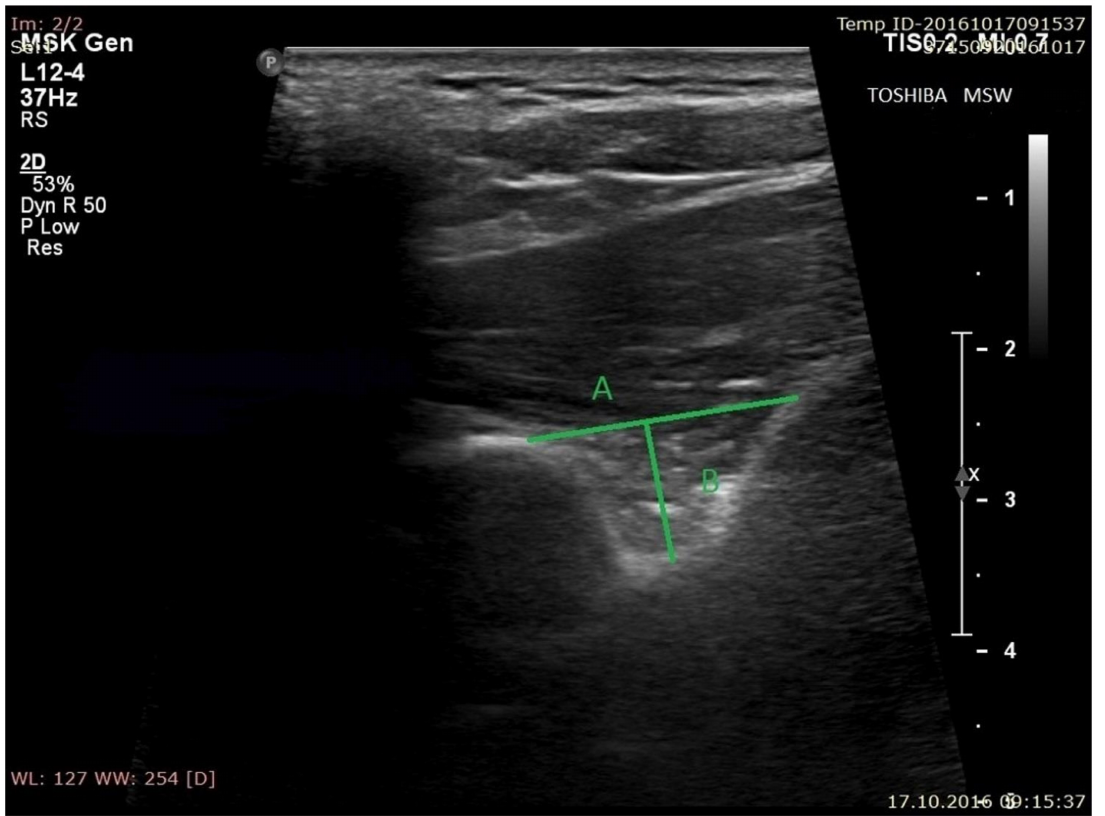
Figure 2. Measurements of suprascapular notch during ultrasonographic investigation. ( A ) the superior transverse diameter (STD); ( B ) the maximal depth